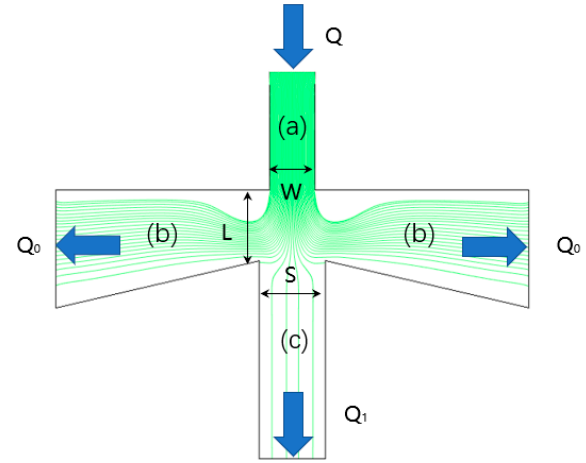
Figure 1. Streamline distribution of particulate matter (PM) with different particle sizes in virtual impactor (VI).